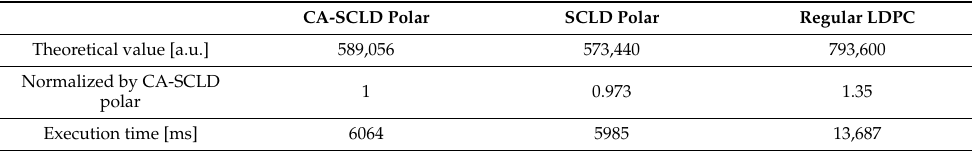
Table 2. Computational cost of error-correcting codes used in the experiment.